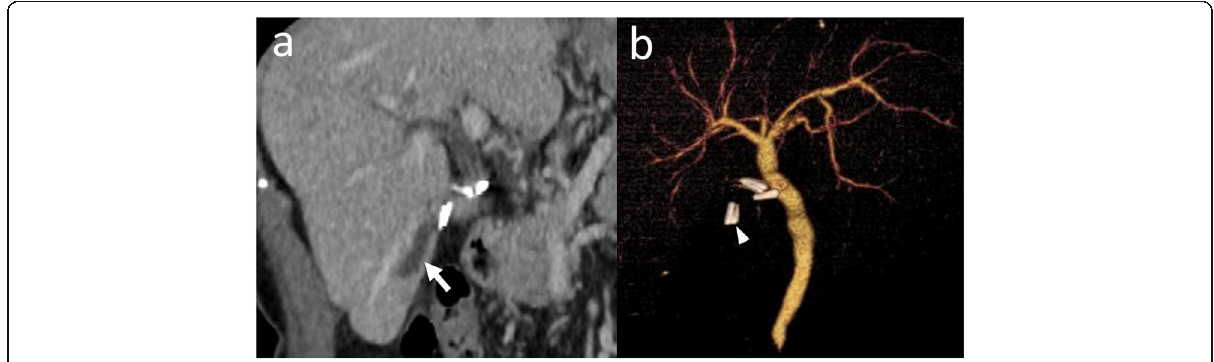
Fig. 3 a The computed tomography scan performed 6 months after the surgery reveals the dilatation of the ventral branch of right posterior inferior segmental bile duct (arrow). b Drip infusion cholecystocholangiography-computed tomography performed on postoperative day 11 reveals the clip on the cholecystohepatic duct (arrowhead) just below the cystic duct